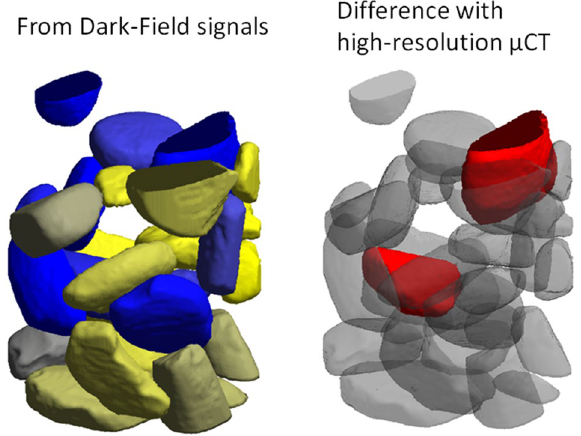
Figure 9. Left: classification from dark-field AFS values (analogous to Fig. 8), color saturation is now scaled by the distance from the classification decision boundary, a grayish color means “close to the decision boundary”. Right: inconsistently classified particles in red. The inconsistently classified particles seem not related to proximity to the decision